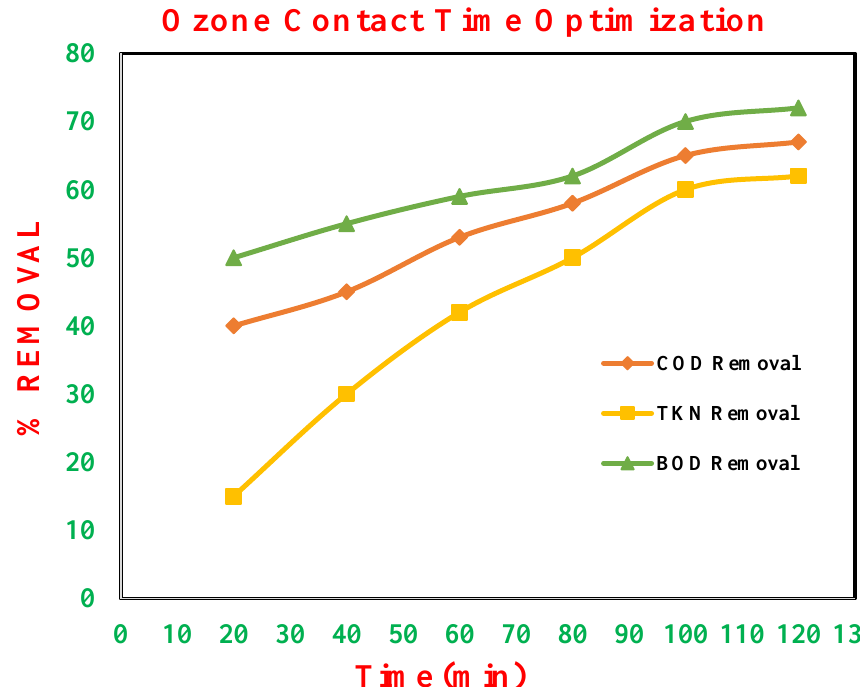
Figure 6. Effect of ozone contact time on the removal of BOD 5 , COD and TKN.